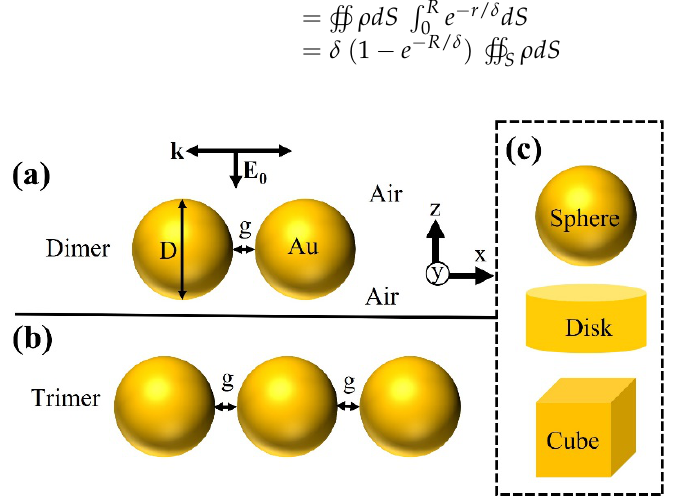
Figure 1. Schematic illustration of free-space ( a ) dimer and ( b ) trimer NPs separated by gap size “g” and diameter “D”. Plane-wave source illuminate plasmonic nanostructures in the normal direction with an incident electric field of E 0 . ( c ) NP shapes modeled in this work are sphere, disk, and cube. Detailed information on modeling conditions is described in Supplementary Materials or SM Figure S1.